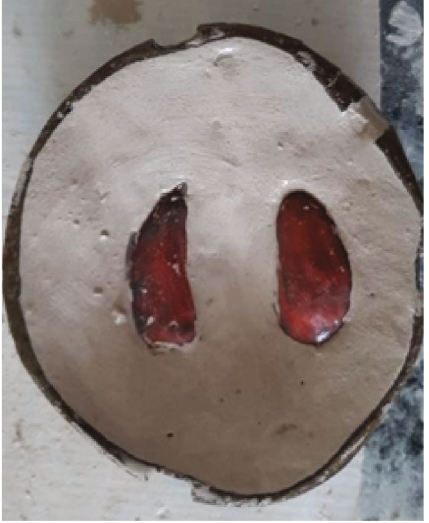
Figure 2: Investment of cheek plumper (wax